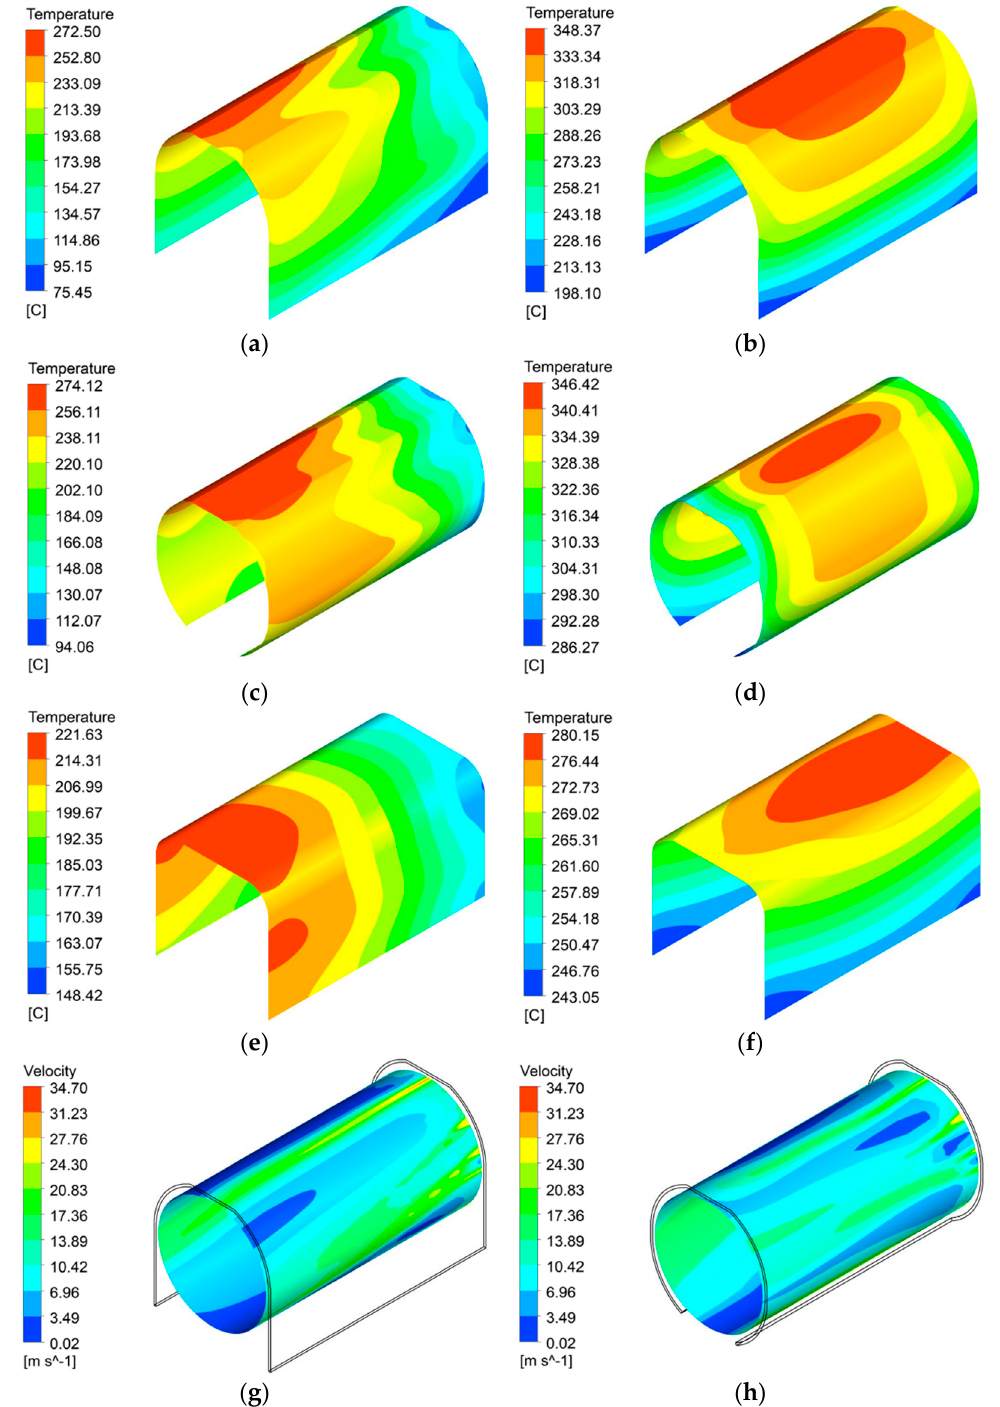
Figure 6. Temperature distribution with different heat exchanger shapes and air flow and velocity distribution between the billet and the heat exchanger ( a ) n-Type forced convection; ( b ) n-Type natural convection; ( c ) o-Type forced convection; ( d ) o-Type natural convection; ( e ) d-Type forced convection; ( f ) d-Type natural convection; ( g ) n-Type forced convection; ( h ) o-Type forced convection.